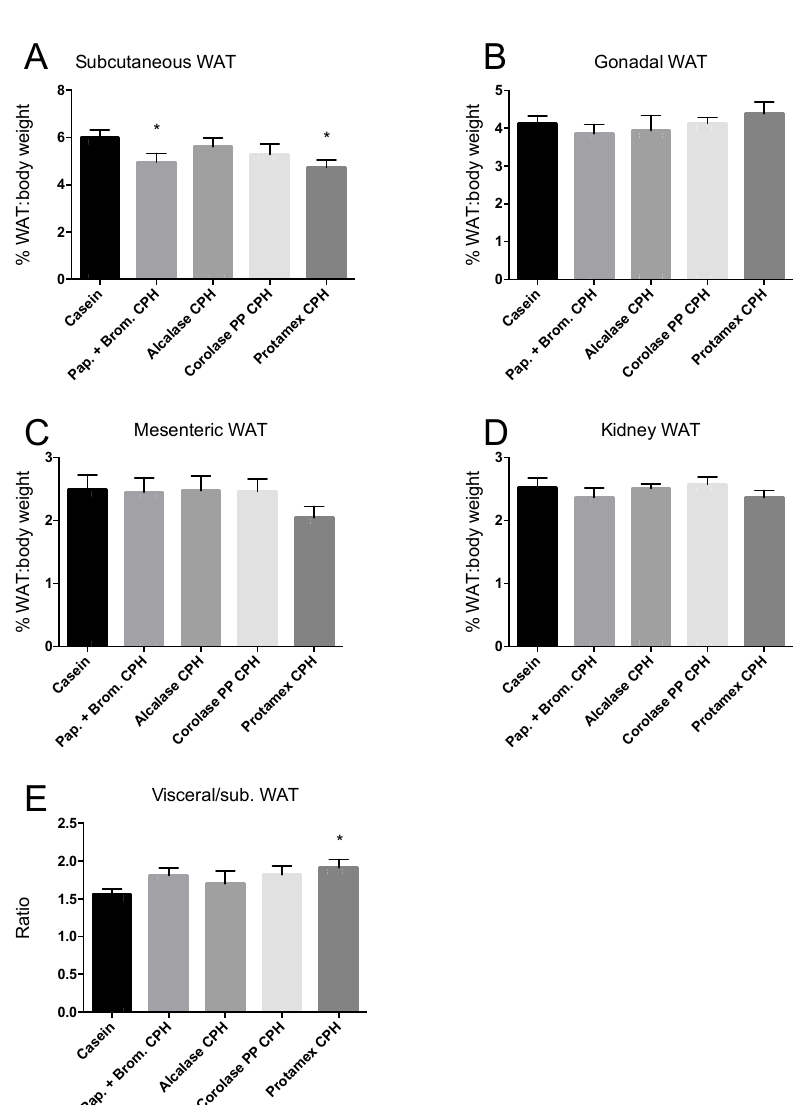
Figure 2. Weight percentage of body weight of white adipose tissue (WAT) depots in C57BL/6 mice fed 19 E% casein- or 9.5 E% casein and 9.5 E% CPH-high fat/high sucrose diets for 12 weeks. ( A ) The subcutaneous WAT depot on the right side of the body from fore- to hindlimb × 2. ( B ) The right side epididymal/gonadal WAT depot × 2. ( C ) The mesenteric WAT surrounding the intestines. ( D ) The right-side WAT depot surrounding and behind the kidney × 2. ( E ) The ratio between the weight percentage of body weight of visceral and subcutaneous WAT depots. Mean values with standard deviation are shown ( n = 11–12). Significant difference between values were determined by one-way ANOVA with Fisher’s LSD test (* p < 0.05).